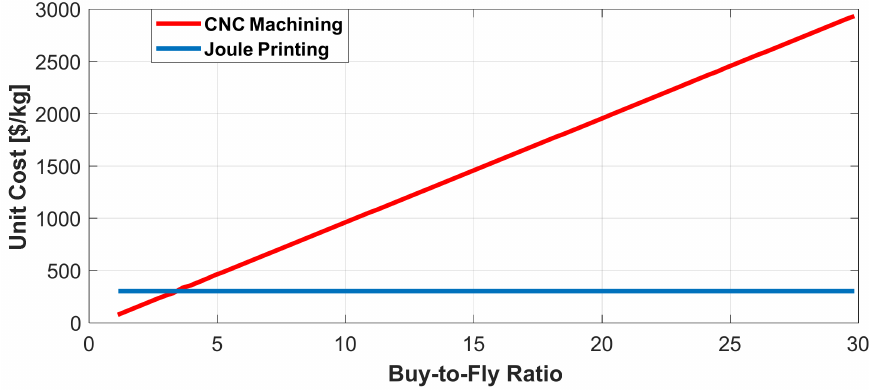
Figure 1. Unit cost as a function of buy-to-fly ratio for titanium